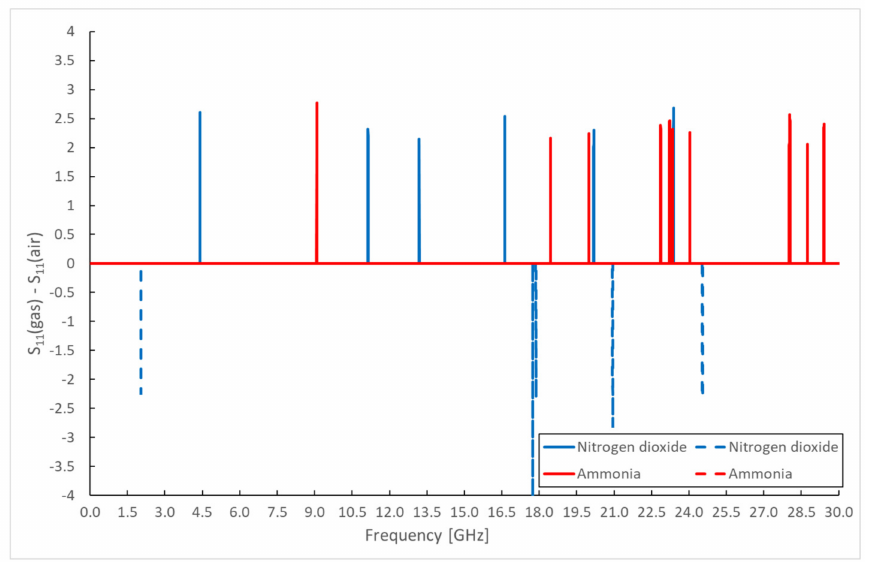
Figure 11. Differential spectrum of sensor response for monitored gases—S 11 parameter